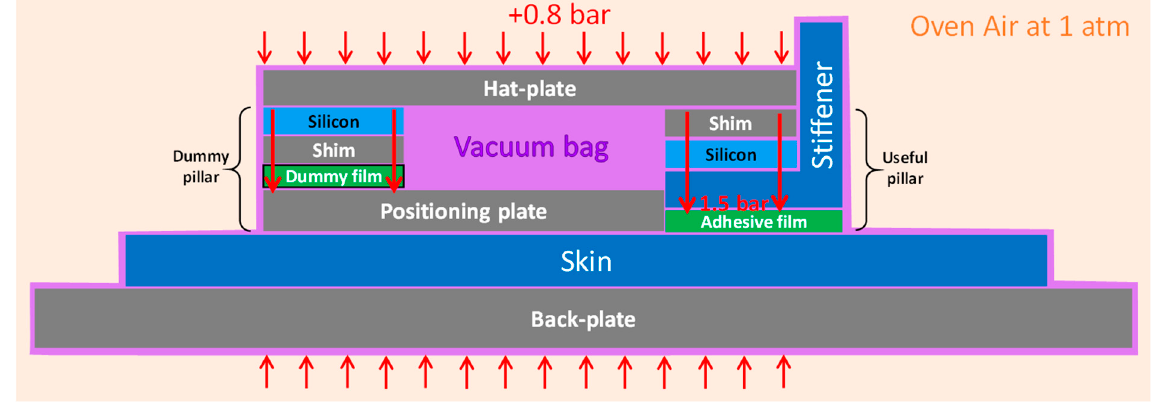
Figure 14. Tooling for pressure amplification on the adhesive film during the bonding process at the oven—cross-section view.